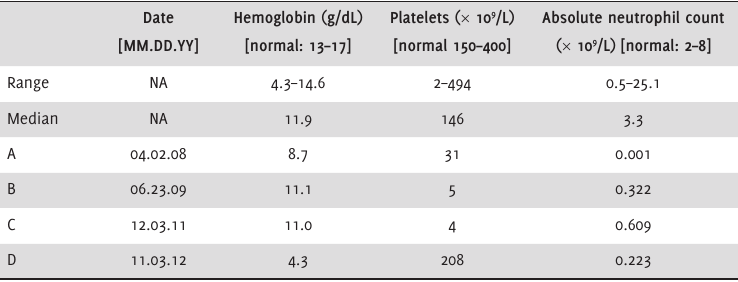
A Trend-line showing the Relationship between Cell Counts and Prednisone Treatment may be found in Figure 2 Table 2. Lymphocyte Phenotyping Results, Showing Positive Double-Negative T (DNT) Cells in a Patient with Probable ALPS, the Laboratory Marker Unique to the